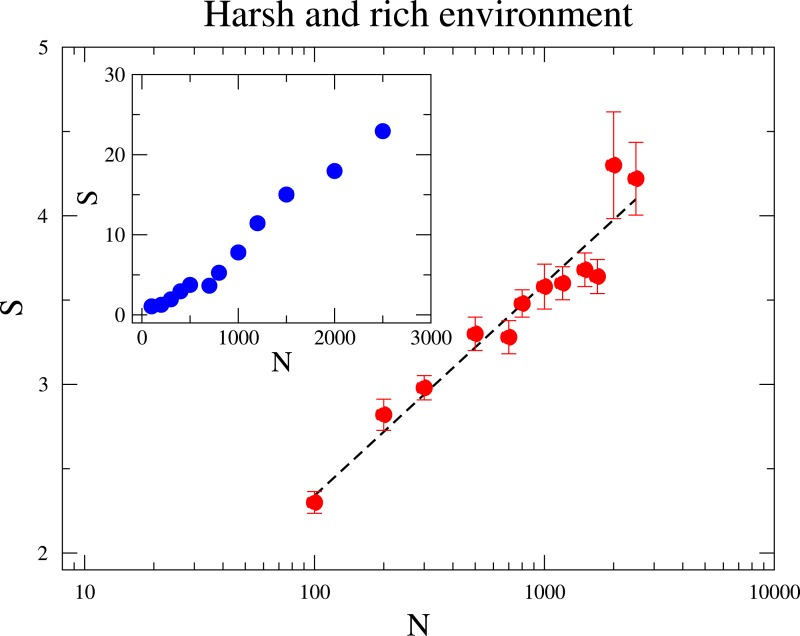
The dependence of the diversity S with the community size N.In the main figure, RMax∕N is fixed to be 1∕2, i.e., RMax is varied as the community size N changes. In the inset RMax is constant and equal to 300. The parameter values are M = 7, Mcons = 2 and mutation rate ν = 1 × 10−6. (The results are averaged over 106 generations after the community has evolved for 108 generations.)